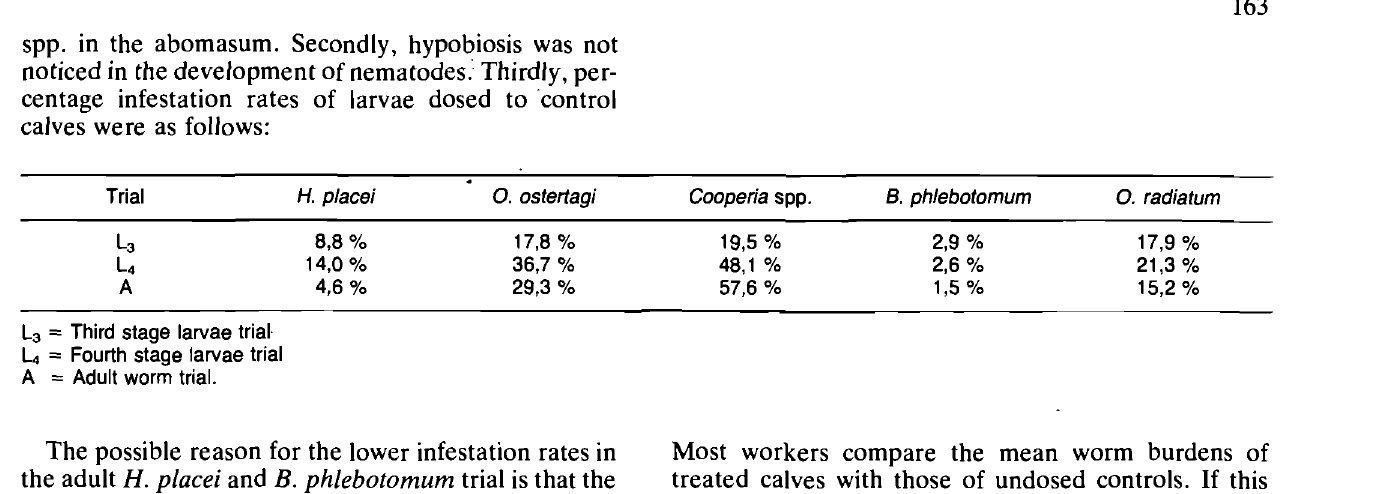
Table 3: MEAN REDUCTION OF WORM BURDENS OF CALVES TREATED WITH FENBENDAZOLE AT 7,5 mg/kg COMPARED WITH UNDOSED CONTROLS Worm species L3 L4 H.